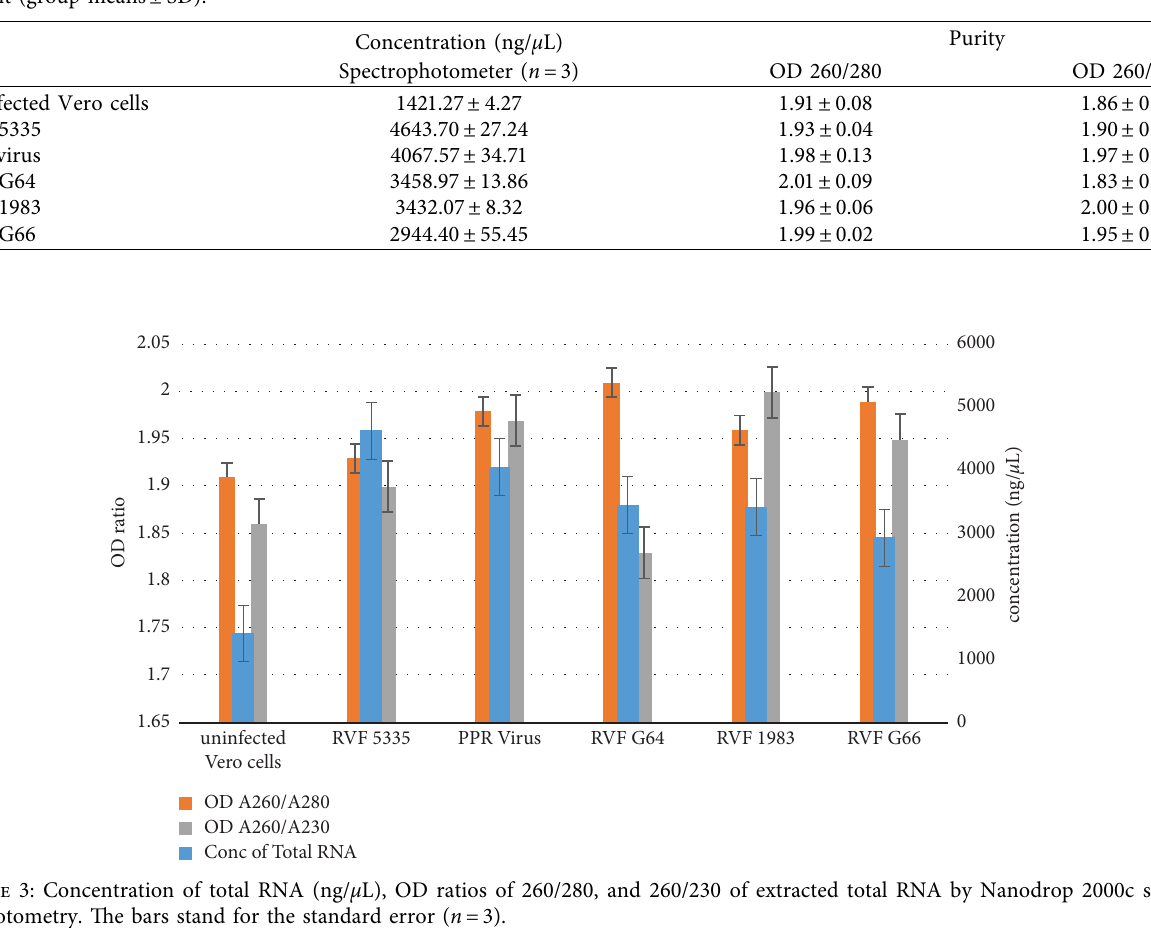
Figure 2: Vero cells as viewed under an inverted microscope (Leitz Labovert), (a) Vero cells without RVFV and (b) Vero cells infected with RVFV after four days. Table 1: Concentration and purity of total RNA extracted from the monolayer of Vero cells infected by diferent viruses using TRIzol reagent (group means ± SD).